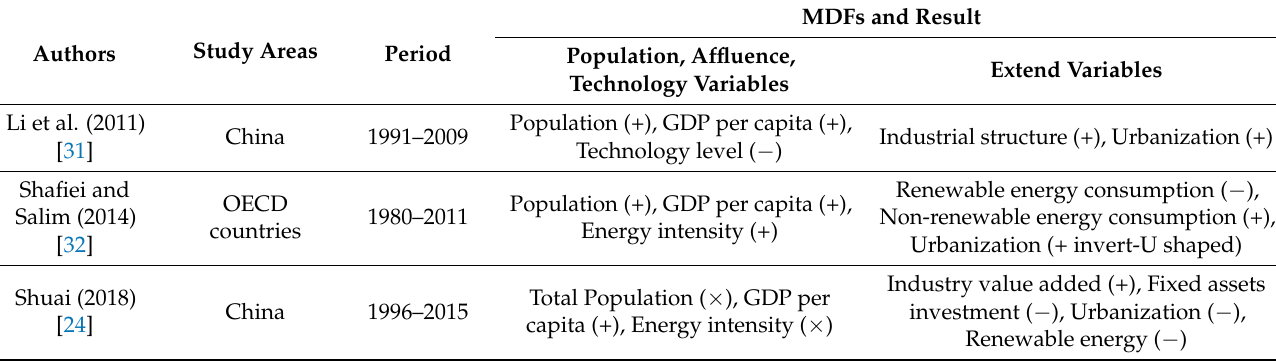
Table 1. Brief summary of previous literature for carbon emission used Extended STIRPAT